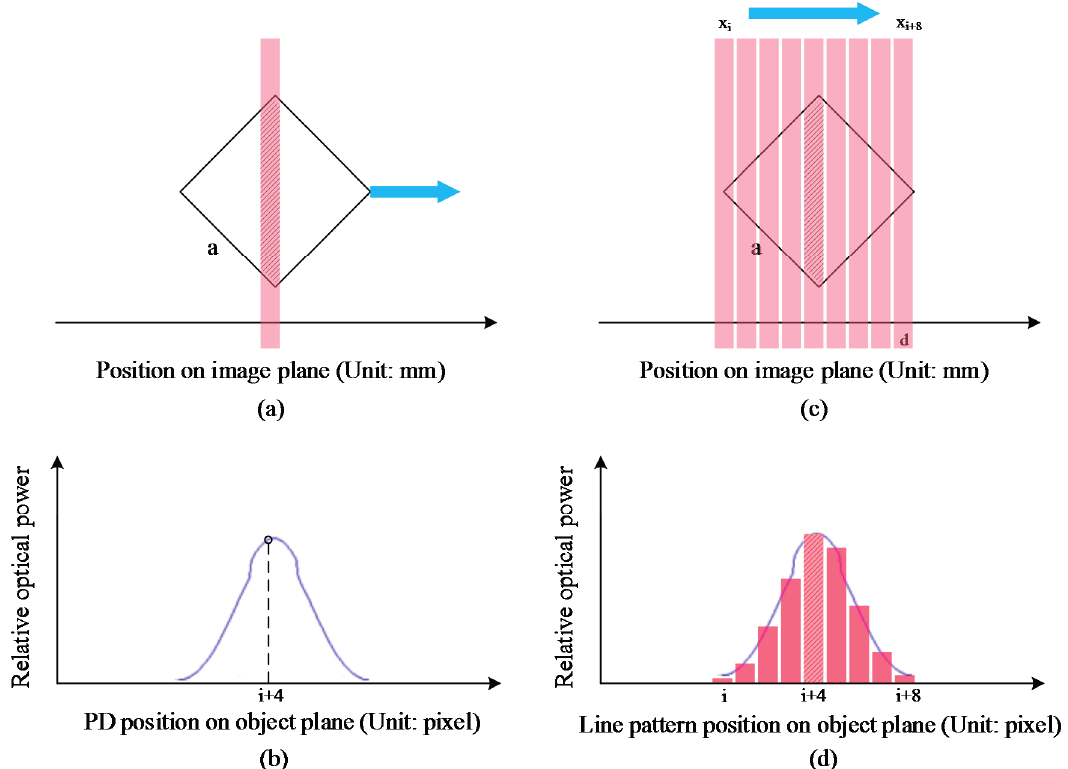
Figure 2. Subpixel coordinates extraction procedure of a VMP. ( a , b ) PD output variation law (the blue optic power curve) of a fixed line pattern and a sweeping PD in horizontal direction; ( c ) Scanning process for pixel coordinates extraction. Only the horizontal pixel gap is illustrated. The shaded area shows the highest optical power of this scanning sequence; ( d ) Optical power data of a scanning sequence. The bars show the relative optical power of the scanning sequence. The envelope of the bars is the theoretical optic power